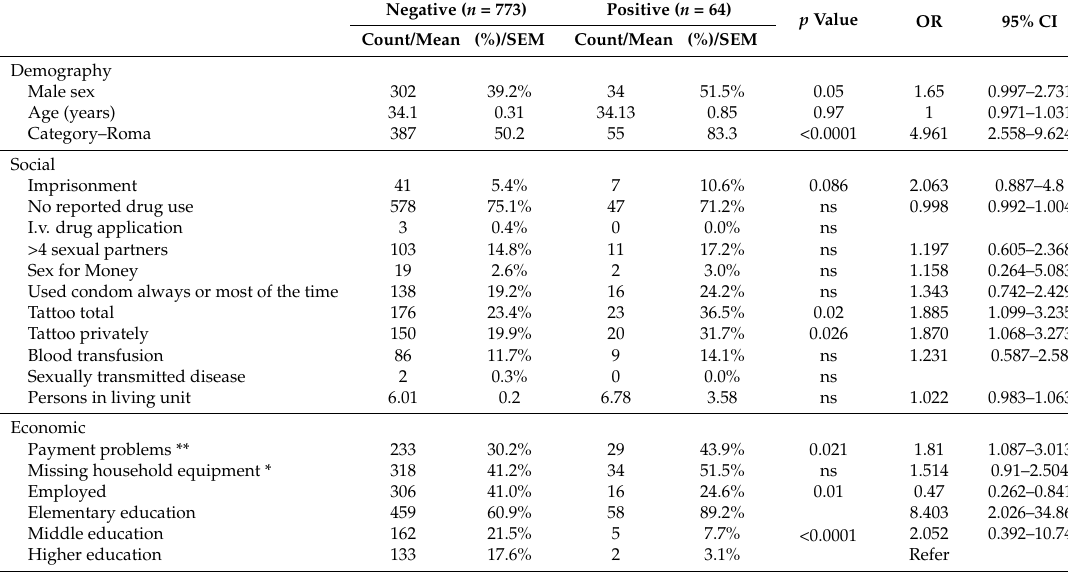
Table 2. Risk factors for HBsAg positivity in the whole study population. SEM—Standard error of mean, CI—Confidence interval, OR—Odds ratio, I.v.—Intravenous.